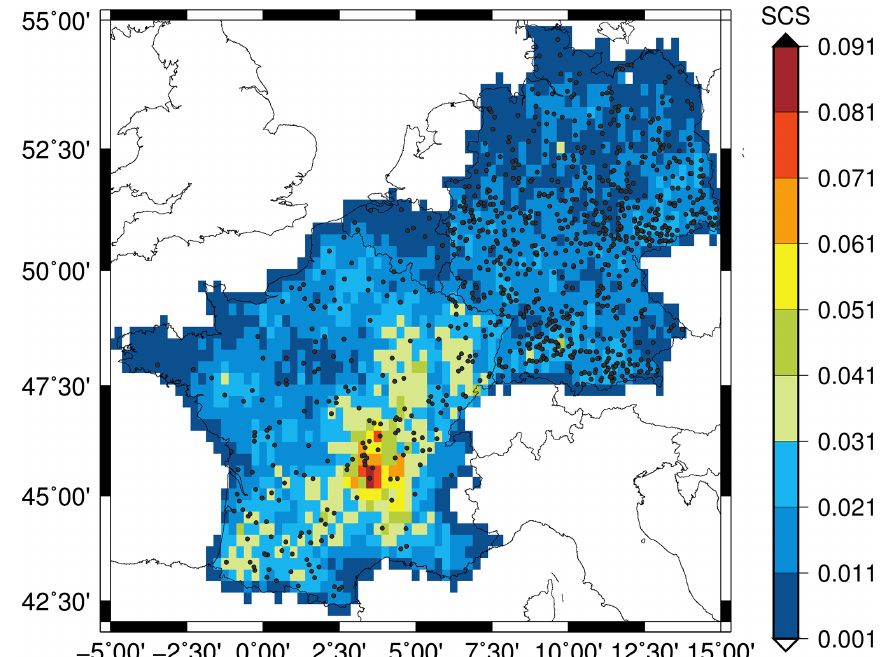
Figure 1. Number of SCSs per year (center of each track) interpolated at 0.25 ◦ × 0.25 ◦ (color bar) and HSs (black dots) between 2005 and 2014 over the investigation area (France, Germany, Belgium, and Luxembourg).